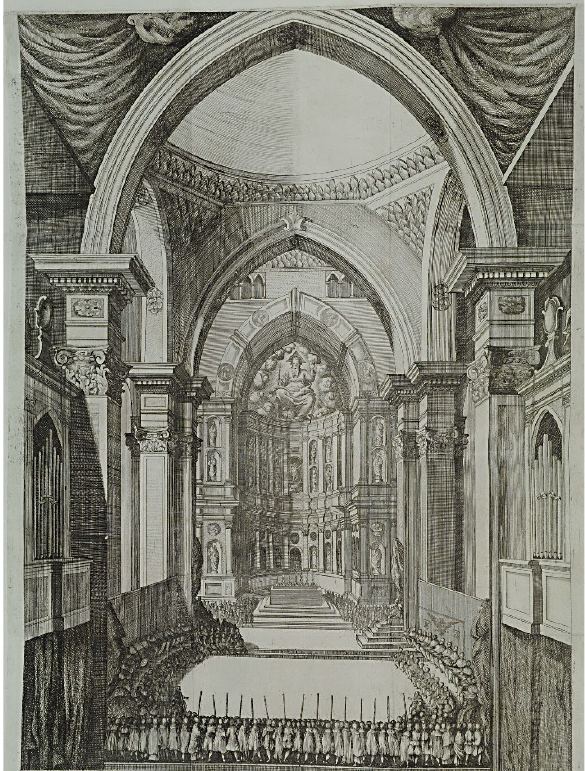
Figure 2. Diego DE LOYA, View of Antonello Gagini’s marble Tribuna in the Cathedral of Palermo